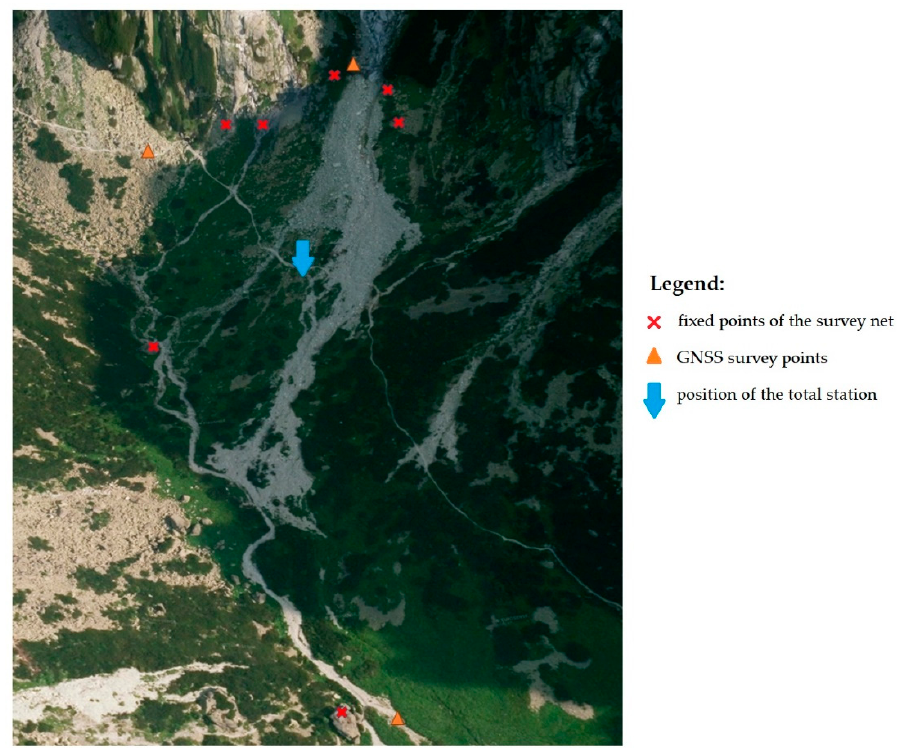
Figure 5. Configuration of the fundamental geodetic network.